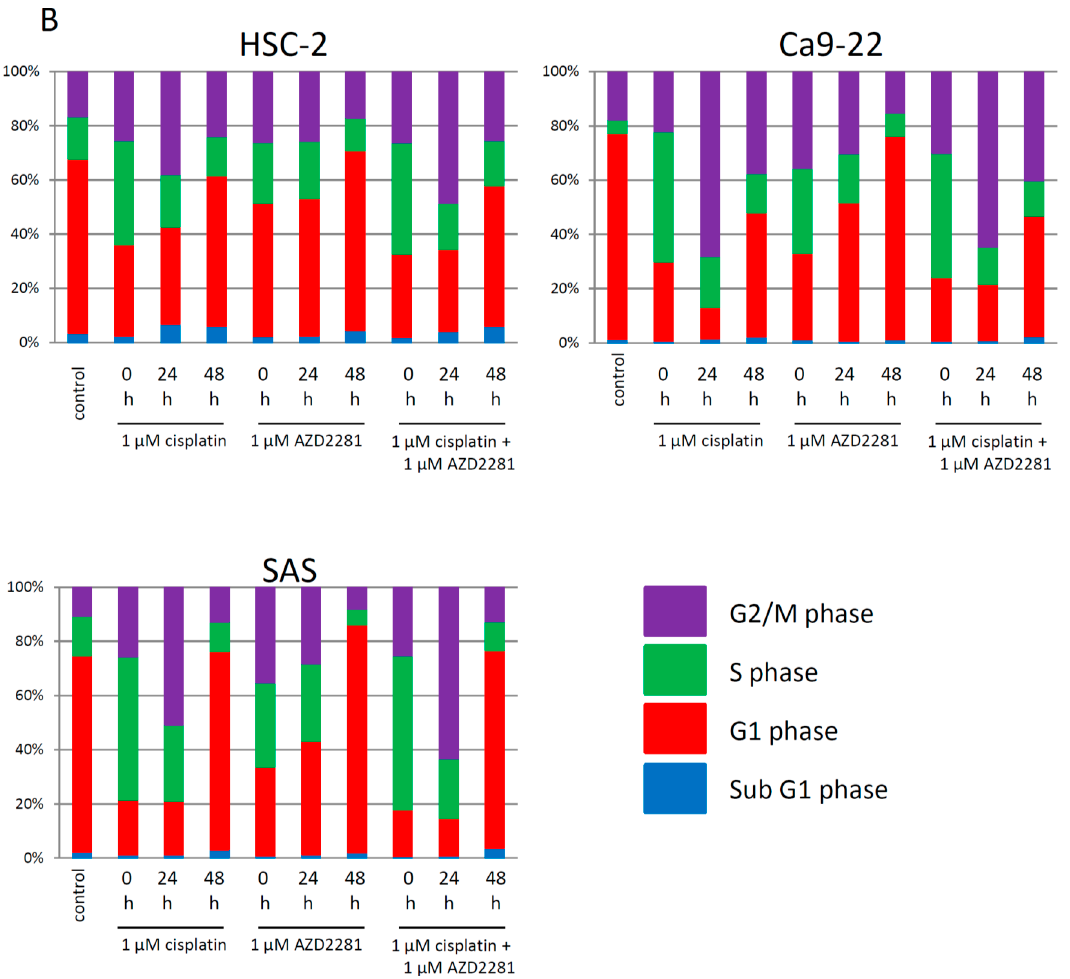
Figure 2. Flow cytometry analysis with propitium iodide after treatment with 1 µM cisplatin, 1 µM AZD2281, and combinatorial administration. The black arrows indicate G2/M arrest and the red arrows indicate S phase arrest ( A ); and percent distributions of cells in each sub G1, G1, S, and G2/M phase in each cell lines ( B ).